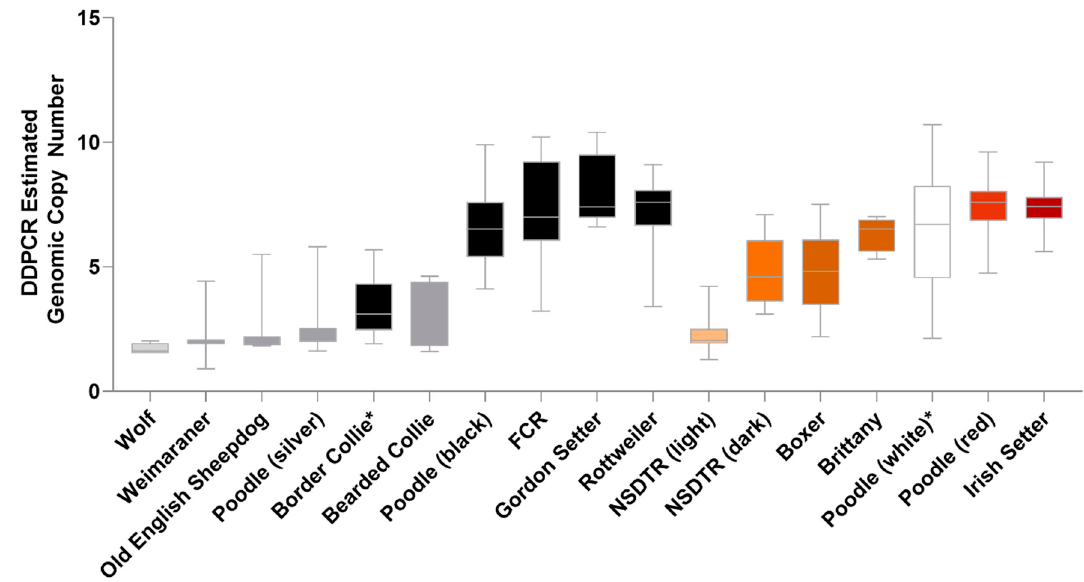
Figure 4. Survey of the digital droplet-estimated genomic copy number in common dog breeds and wolves. Breeds known to segregate light and dark coat colors in eumelanin and / or pheomelanin-based colors were separated by color. Breeds are color coded by an approximation of the overall coat color, and sample numbers are provided in Table S1. * Breeds whose copy number estimates did not seem to match their coat colors.